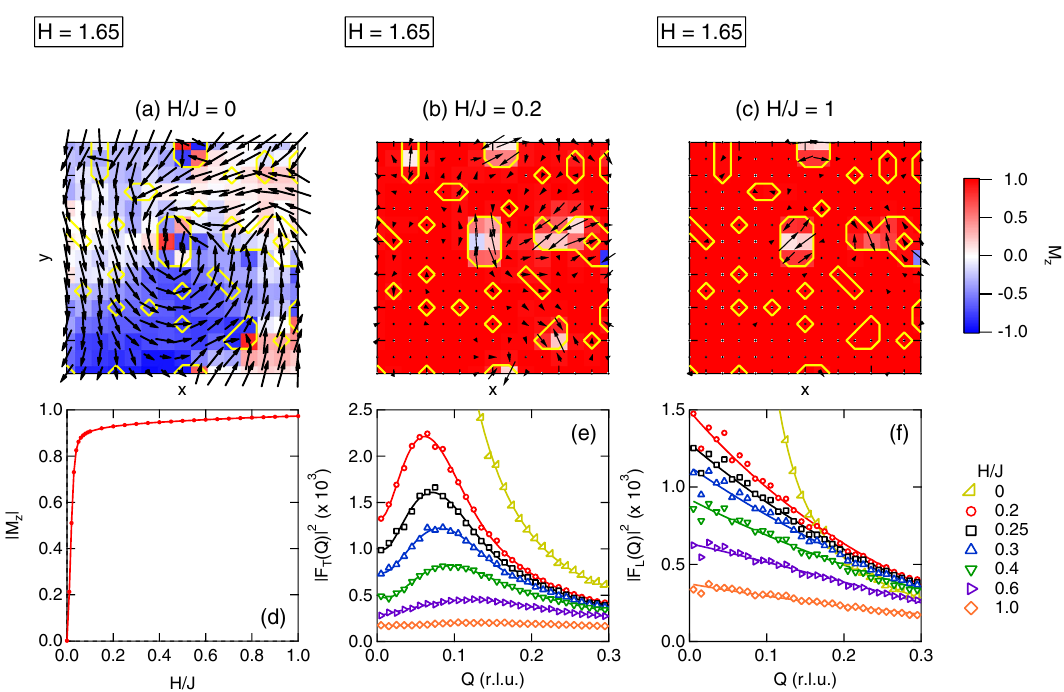
Figure 4. Spin configurations and Fourier analysis of the MC simulations—( a–c ) Snapshot of a spin configuration ( 15 × 15 spins) obtained on a x = 0.23 sample ( c AFM ≈ 0.05 ) at T / J = 0.01 for ( a ) H / J = 0 , ( b ) H / J = 0.2 (slightly above technical saturation) and ( c ) H / J = 1 . Arrows represent the in-plane magnetization while color map shows the out-of-plane ( i.e. , parallel to the applied magnetic field) component M Z . Yellow lines border the regions where impurity spins are located, anchoring the field-induced localized vortex-like textures (see text). ( d ) Field-dependence of the average longitudinal magnetization | M Z | . ( e, f ) Squared Fourier transforms of the transverse ( e ) and longitudinal ( f ) spin correlations for different values of H / J , here averaged over 40 realizations (see Methods and Supplementary Information with Supplementary Figures S9 and